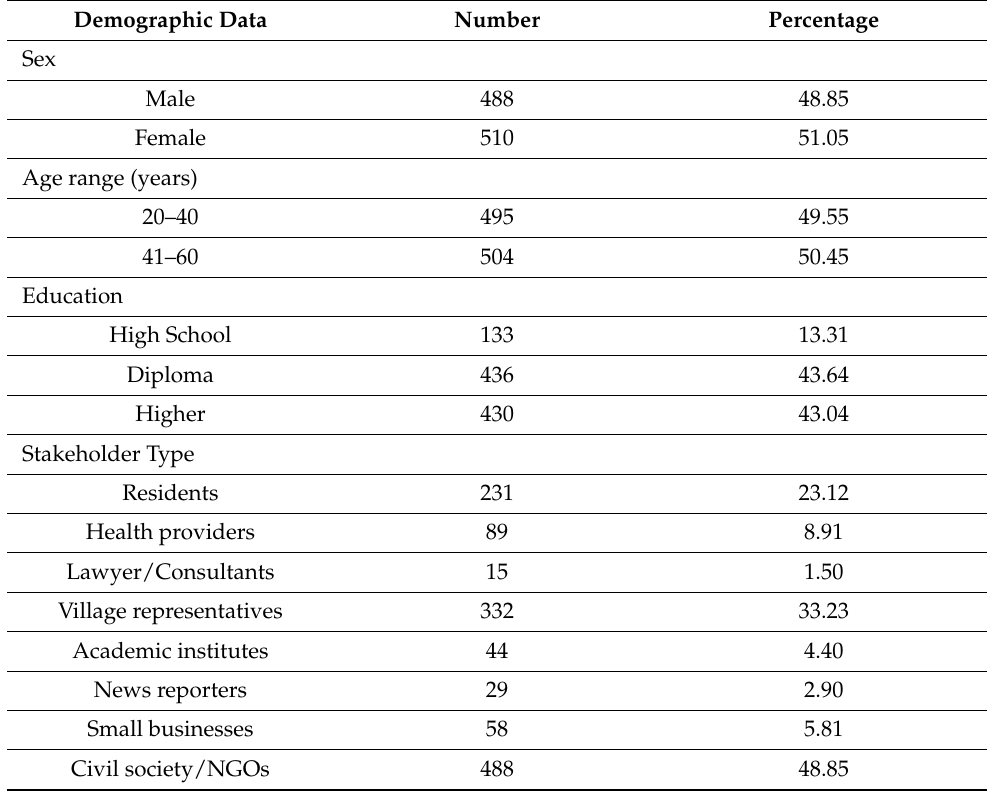
Table 1. Characteristics of respondents (N =